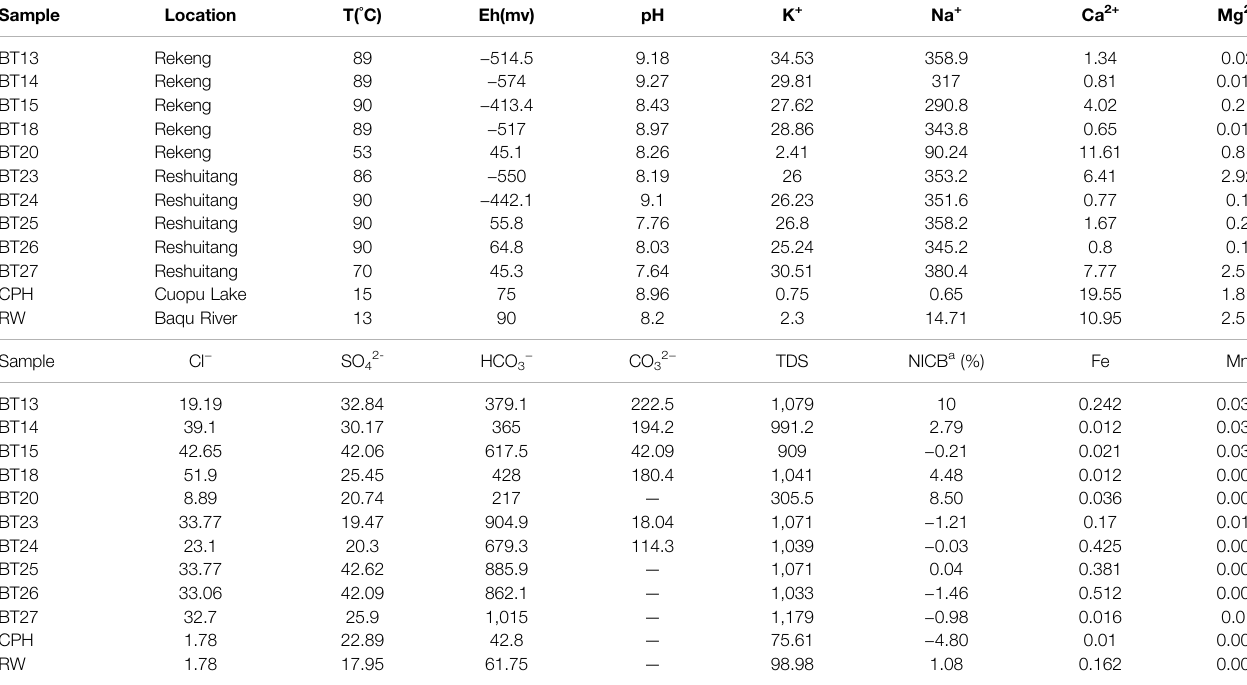
TABLE 1 | Hydrochemical composition of water samples in the study area (mg/L).